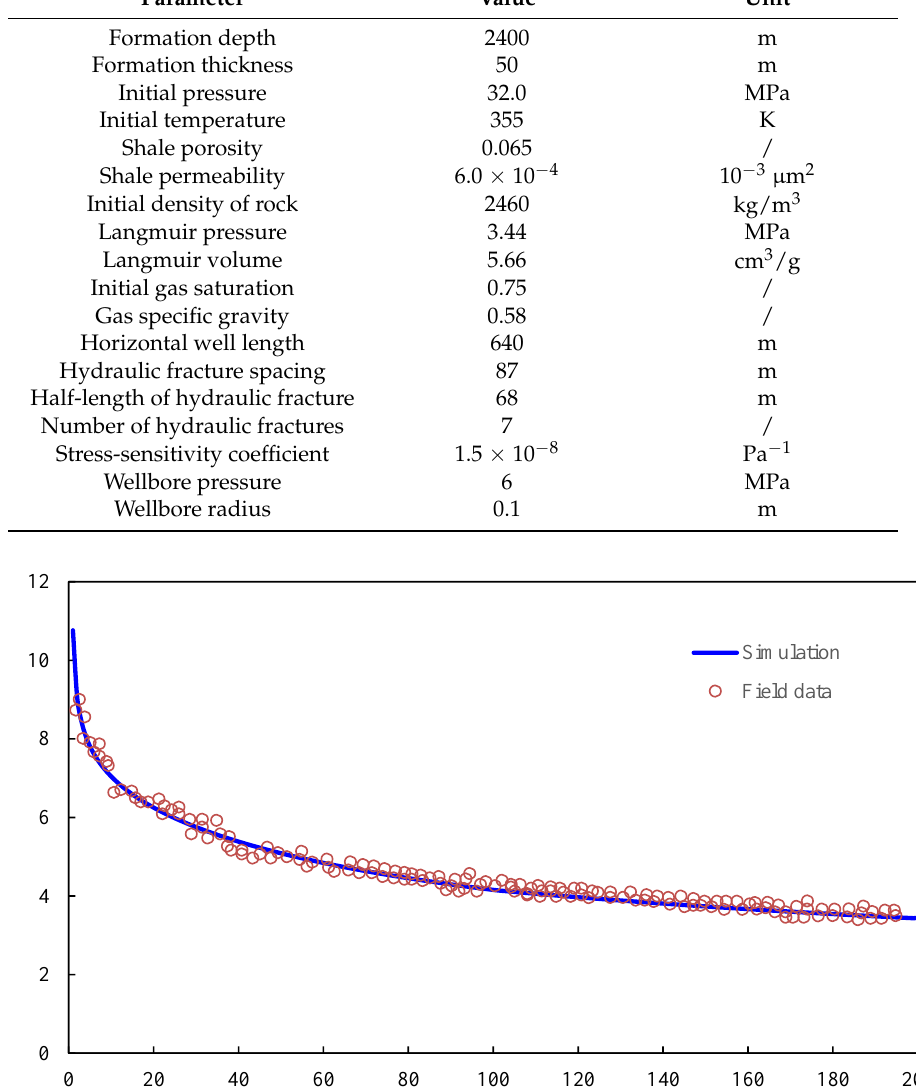
Table 2. Basic parameters for the numerical simulation.